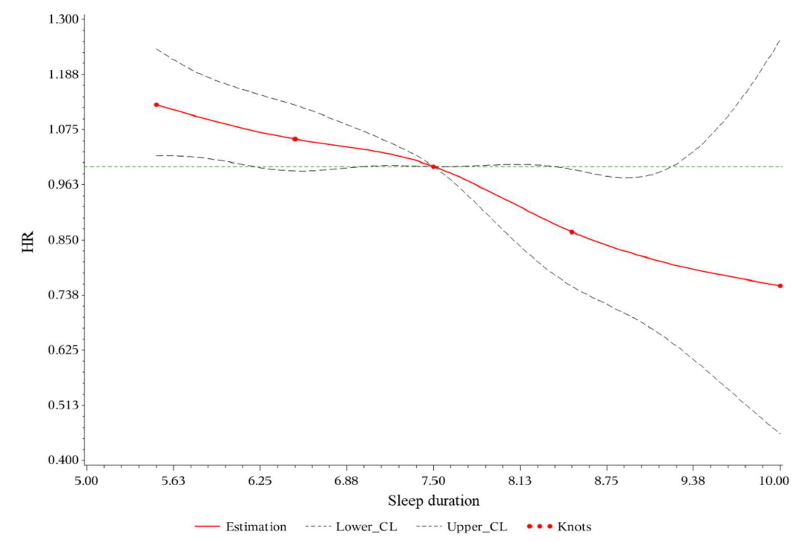
Figure 2. Restricted cubic spline plots for hyperuricemia by sleep duration. HR indicates hazard ratio; CL, confidence limit. Multivariable Cox regression models with restricted cubic splines show the hazard ratio for the incidence of hyperuricemia adjusted for sex, age, education level, personal income, marital status, smoking status, drinking status, exercise status, Body Mass Index, abdominal circumference, hypertension, diabetes, triglycerides, high-density lipoprotein cholesterol, and amount of white blood cells. The dotted lines indicate 95% CL. The x-axis represents the sleep duration. The y axis represents the HR of hyperuricemia.